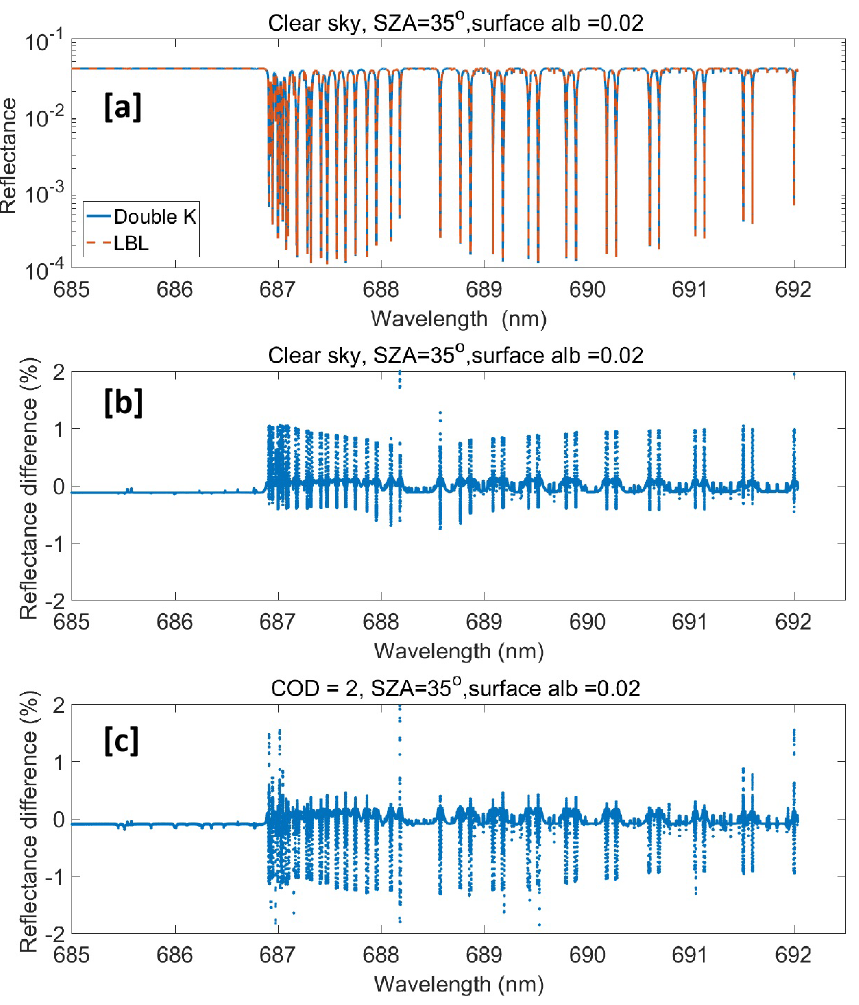
Figure 2. (a) High-resolution reflectance at the EPIC O 2 B band simulated by a fast radiative model (double- k ) and benchmark (LBL). Difference between the simulated reflectance by (b) double- k and LBL for a clear-sky case and (c) a thin liquid water cloud case with COD 2. Here the SZA and view angle are 35 ◦ , the surface albedo is 0 . 02, the aerosol optical depth is 0 . 08, and the reflectance difference (%) is 100 · (( double − k) − LBL )/